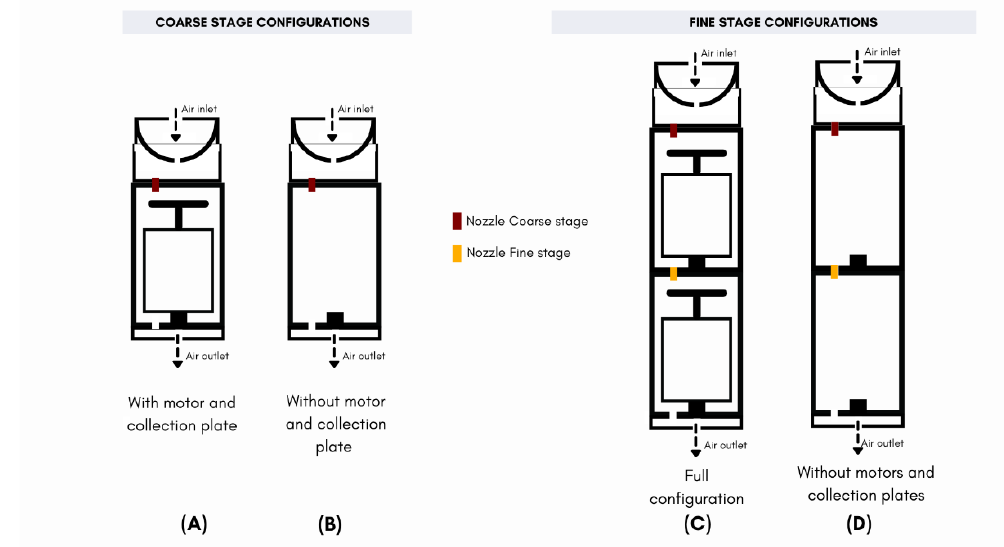
Figure 4. Schematic representation of the four configurations used for the experimental determination of the collection efficiency. The nozzles of the coarse and fine stages are represented, respectively, in red and yellow. The motors and plates were removed in configurations ( B , D ), while the stages were fully assembled (with all their nozzles, motors and collection plates) in configurations ( A , C ).